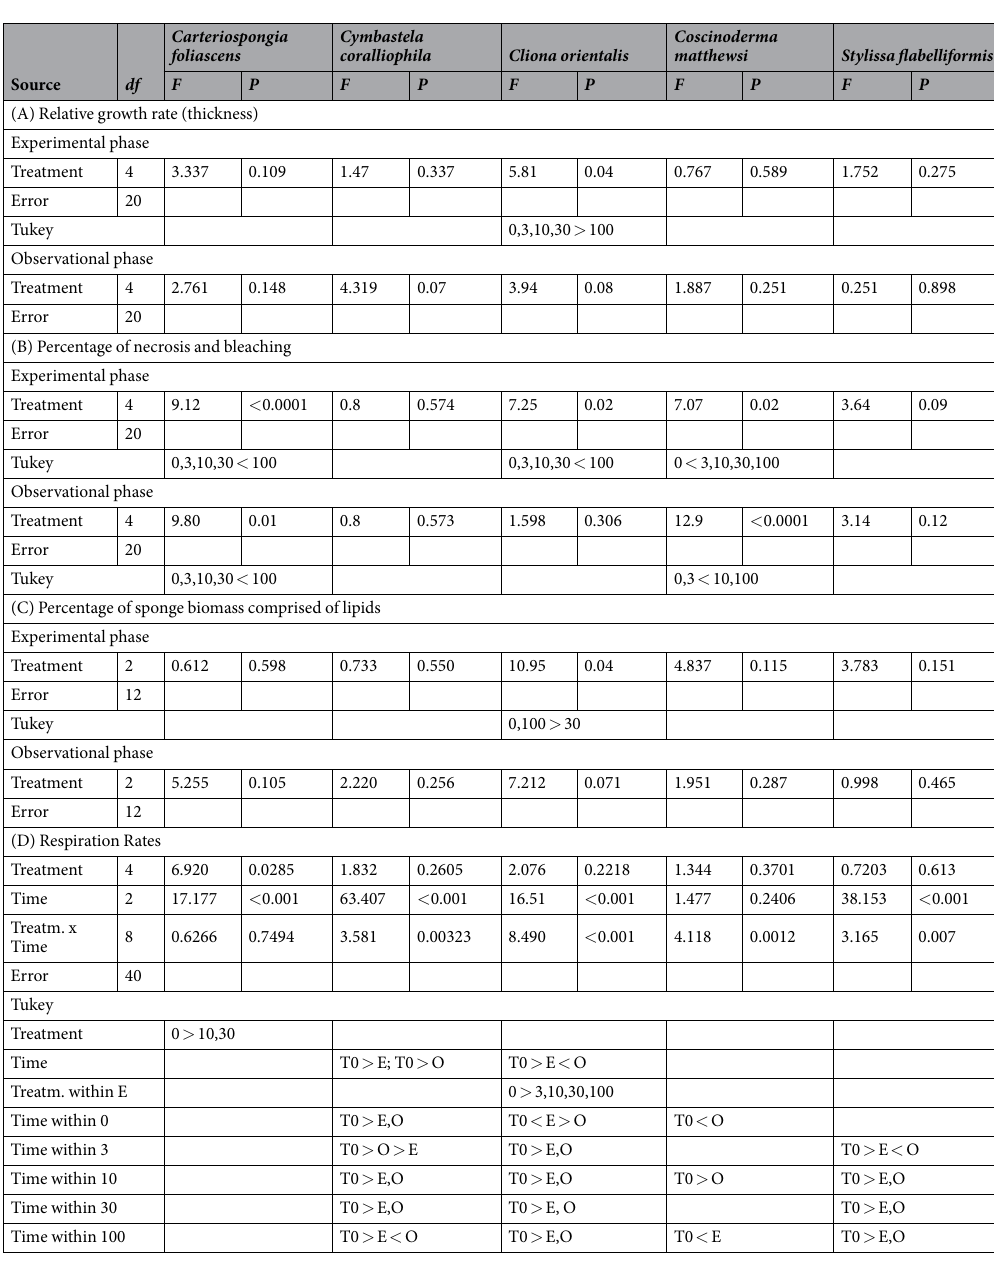
Table 1. ANOVA tables and summaries of linear mixed models testing the effects of different SSCs on the physiological responses of sponges. (A) Growth rate based on thickness measures, (B) Percentage of necrotic and bleached tissue, (C) Percentage of sponge biomass comprised of lipids, (D) Mean respiration rates, for each species separately, at the end of experimental phase (E) and observational phase (O). Tukey tests were performed for significant pairwise multiple comparisons. (SSC: 0, 3, 10, 30 and 100 mg L − 1